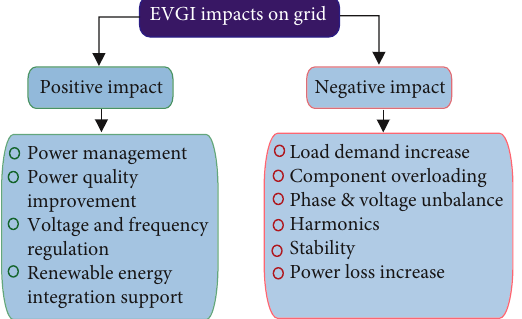
Figure 6: Negative and positive impacts of EV grid integration system. Redrawn from this source